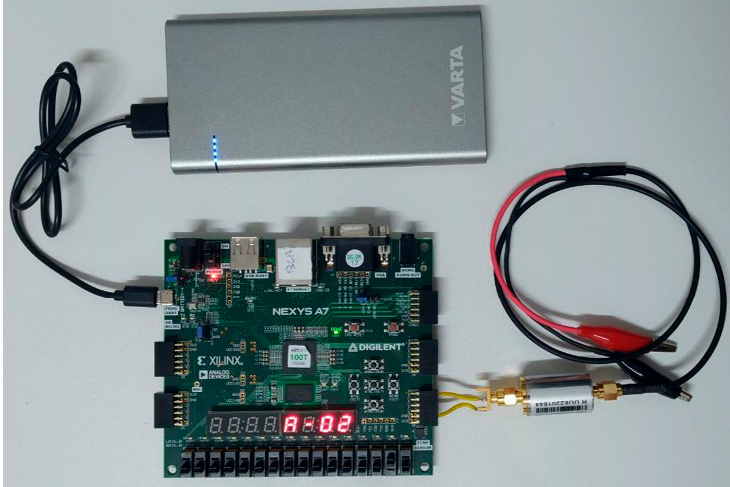
Figure 7. Experimental prototype: transmitter module.